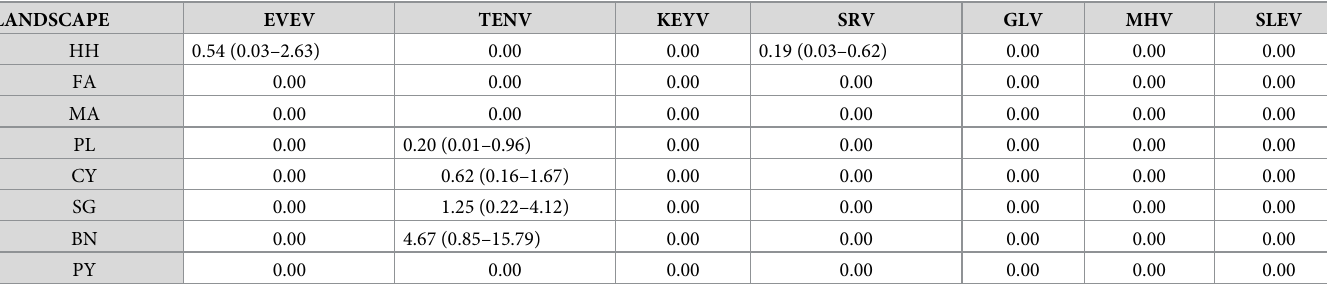
Table 3. Minimum infection rate per 1,000 mosquitoes (95% CI) among landscapes 2014.